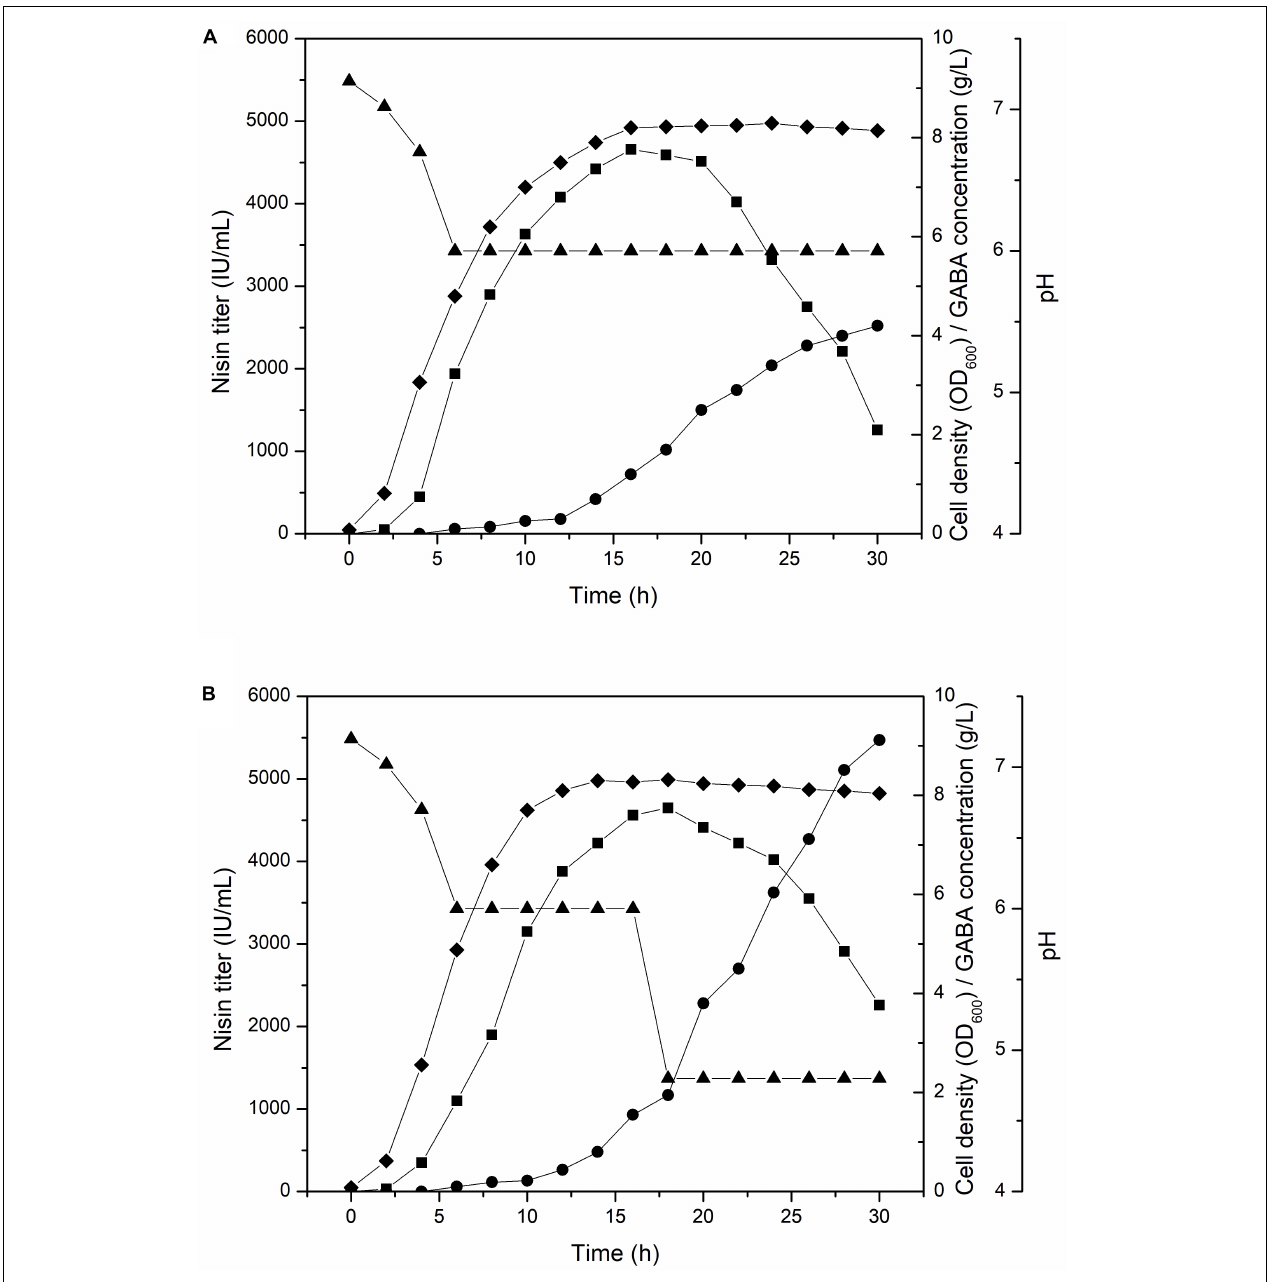
FIGURE 3 | Time profile of cell density (diamond), nisin titer (square), GABA concentration (circle), and pH (triangle) of F44/GadB1C1 in 5-L fermentor using different pH control strategy. (A) Maintaining pH 6 and (B) adjusting pH to 4.8 at 16